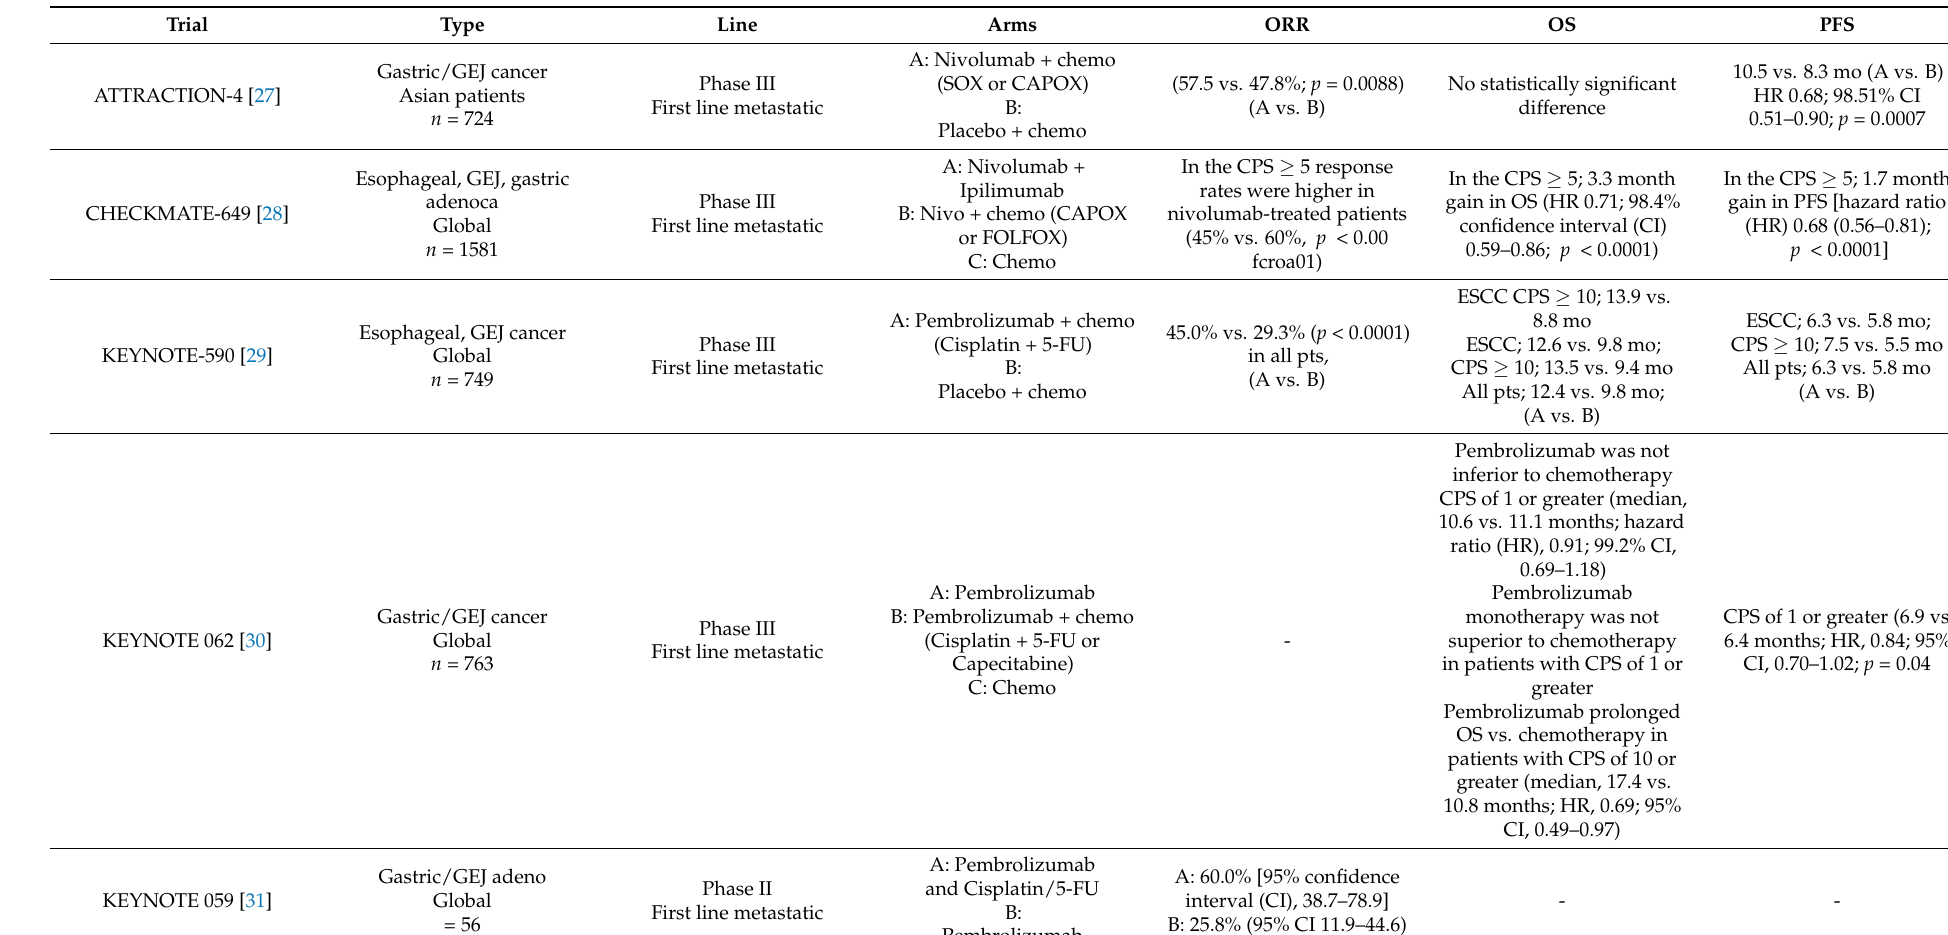
Table 2. Summary of relevant outcomes from immunotherapy trials in the advanced esophagogastric